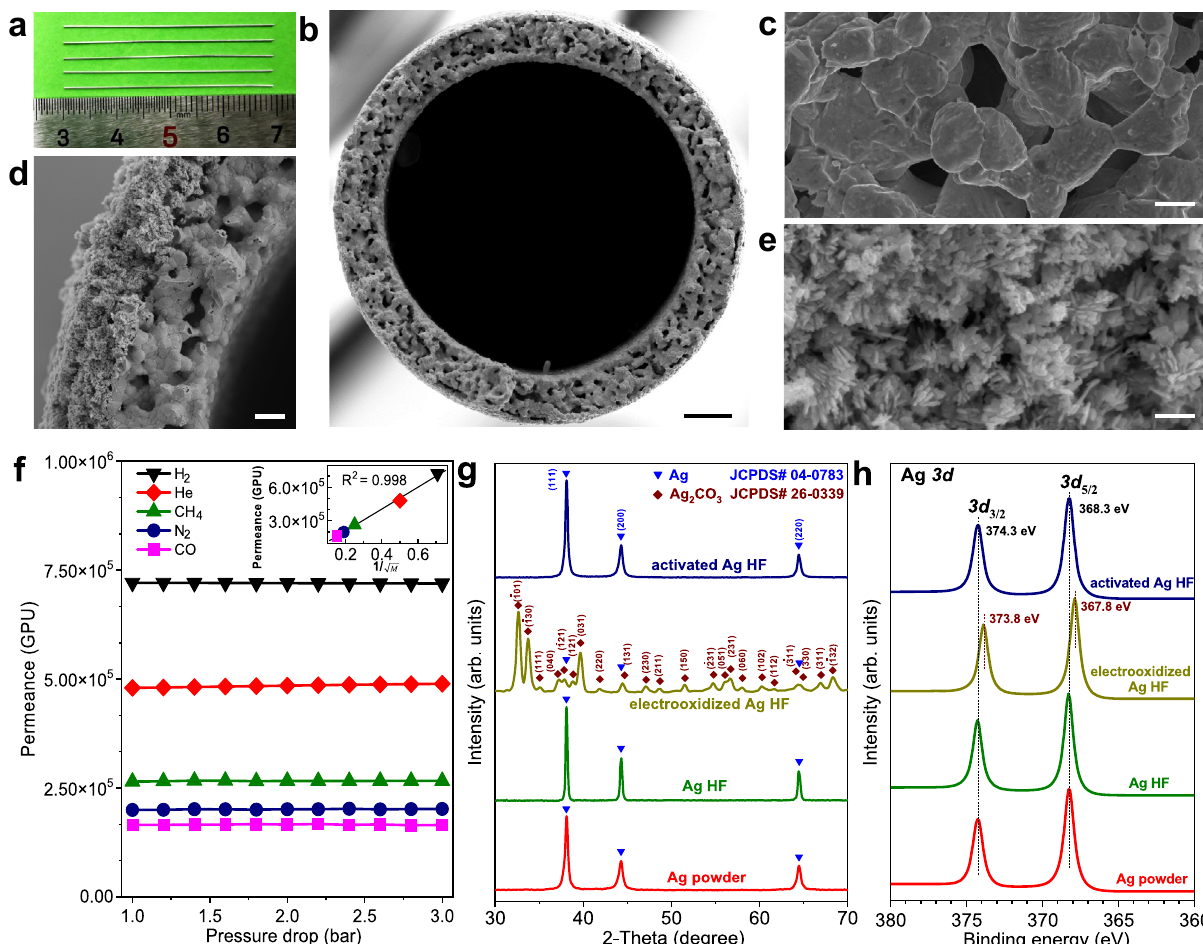
Fig. 2 Structural and compositional characterization. a Optical image of the as-fabricated Ag HF tubes. SEM images of b , d , cross sections and c , e , outer surfaces of b , c , Ag HF and d , e , activated Ag HF. Scale bars in b , c , d and e are 50 µ m, 5 µ m, 10 µ m and 500 nm, respectively. f Gas permeances of activated Ag HF. GPU denotes gas permeation unit. Inset: the permeances (at 1.0 bar) are proportional to the inverse square root of gas molecular weight. g XRD patterns, and h , XPS spectra of Ag HF and activated Ag